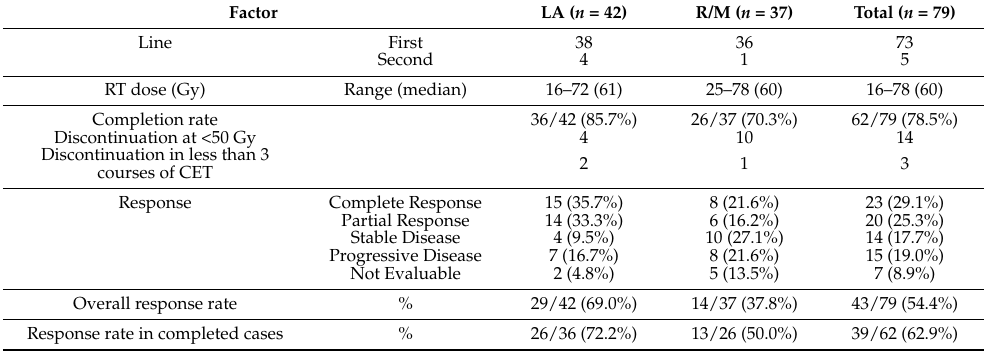
Table 3. Treatment and response rate.